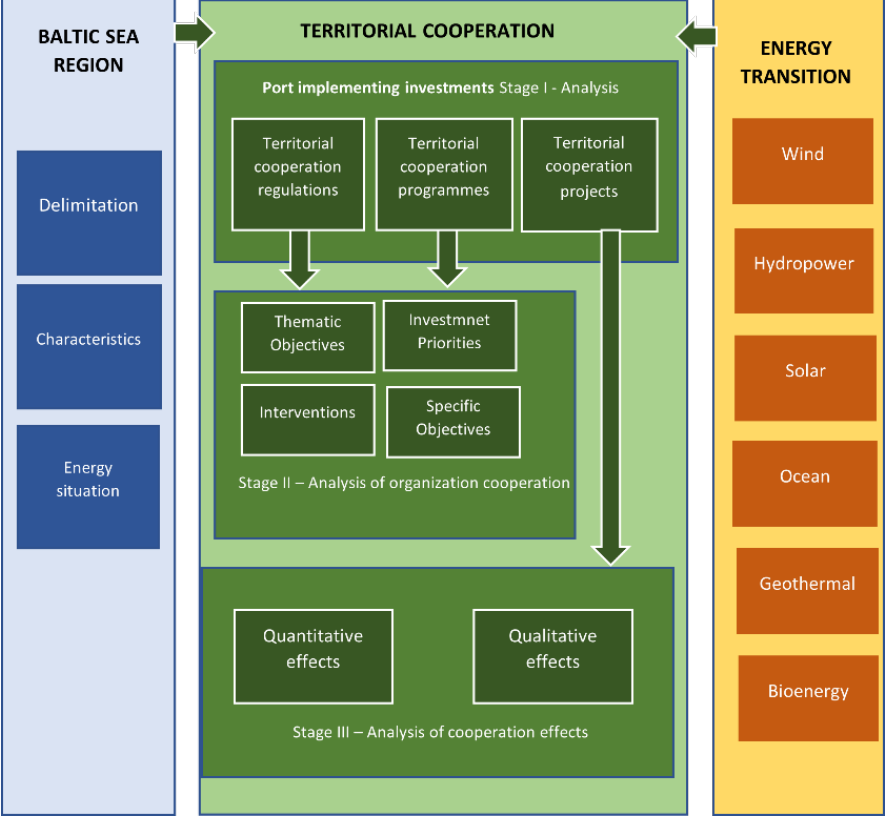
Figure 4. Research model. Source: own study.